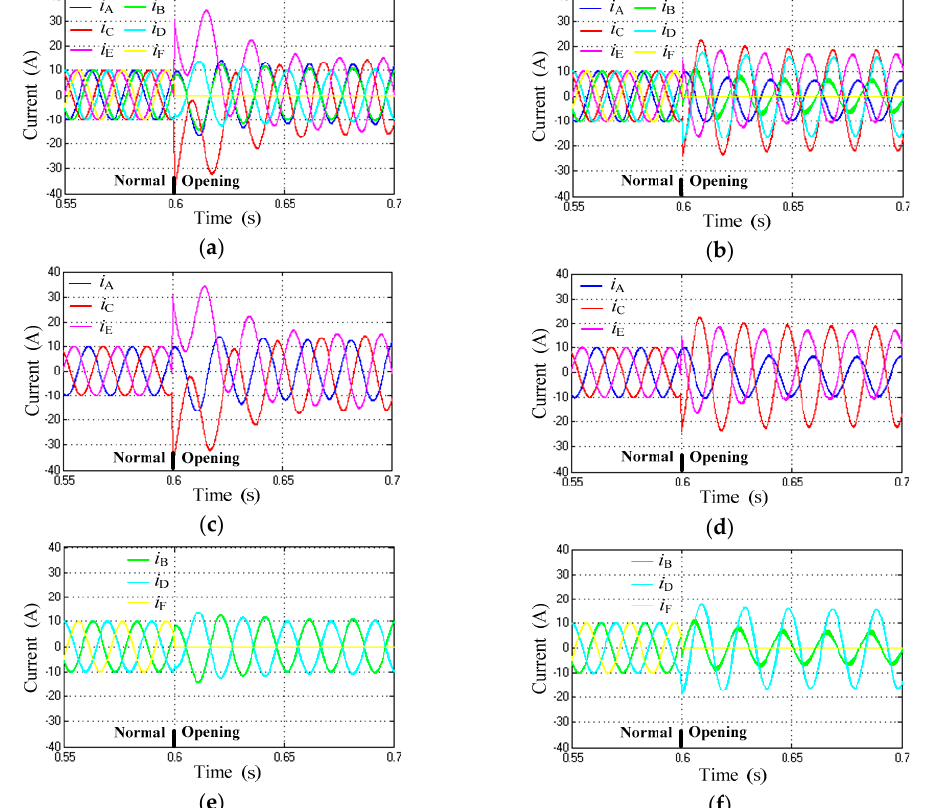
Figure 11. Stator winding currents in simulations 1 and 2. ( a ) Stator winding currents in simulation 1; ( b ) Stator winding currents in simulation 2; ( c ) ACE-winding currents in simulation 1; ( d ) ACE-winding currents in simulation 2; ( e ) BDF-winding currents in simulation 1; ( f ) BDF-winding currents in simulation